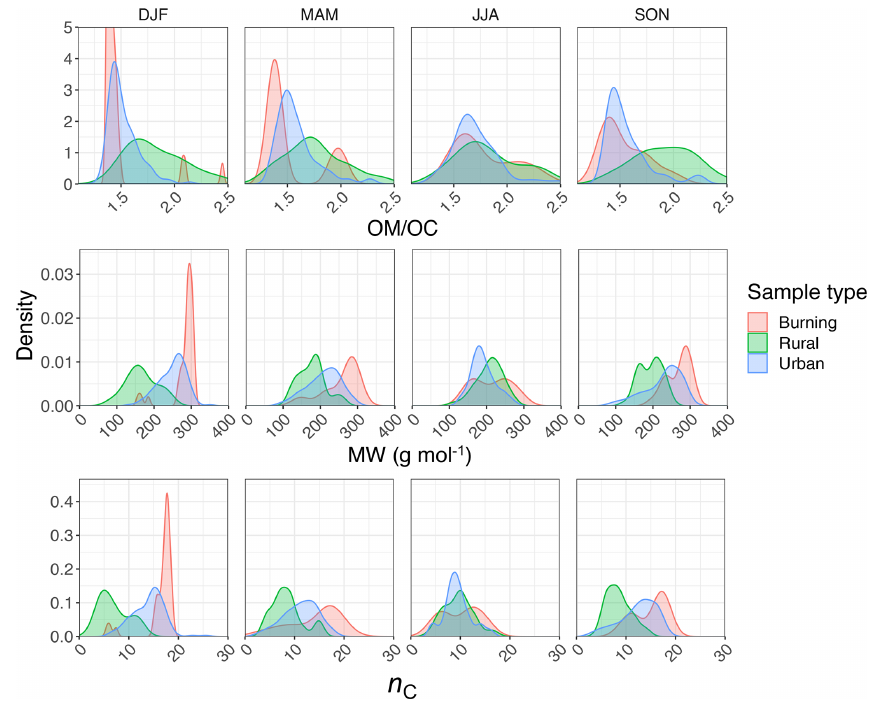
Figure 14. Kernel density estimates of indirect OM / OC ratio, MW, and n C estimated from normalized aliphatic C − H mid-infrared ab- sorbances by PLSR models (segregated by sample type and season).